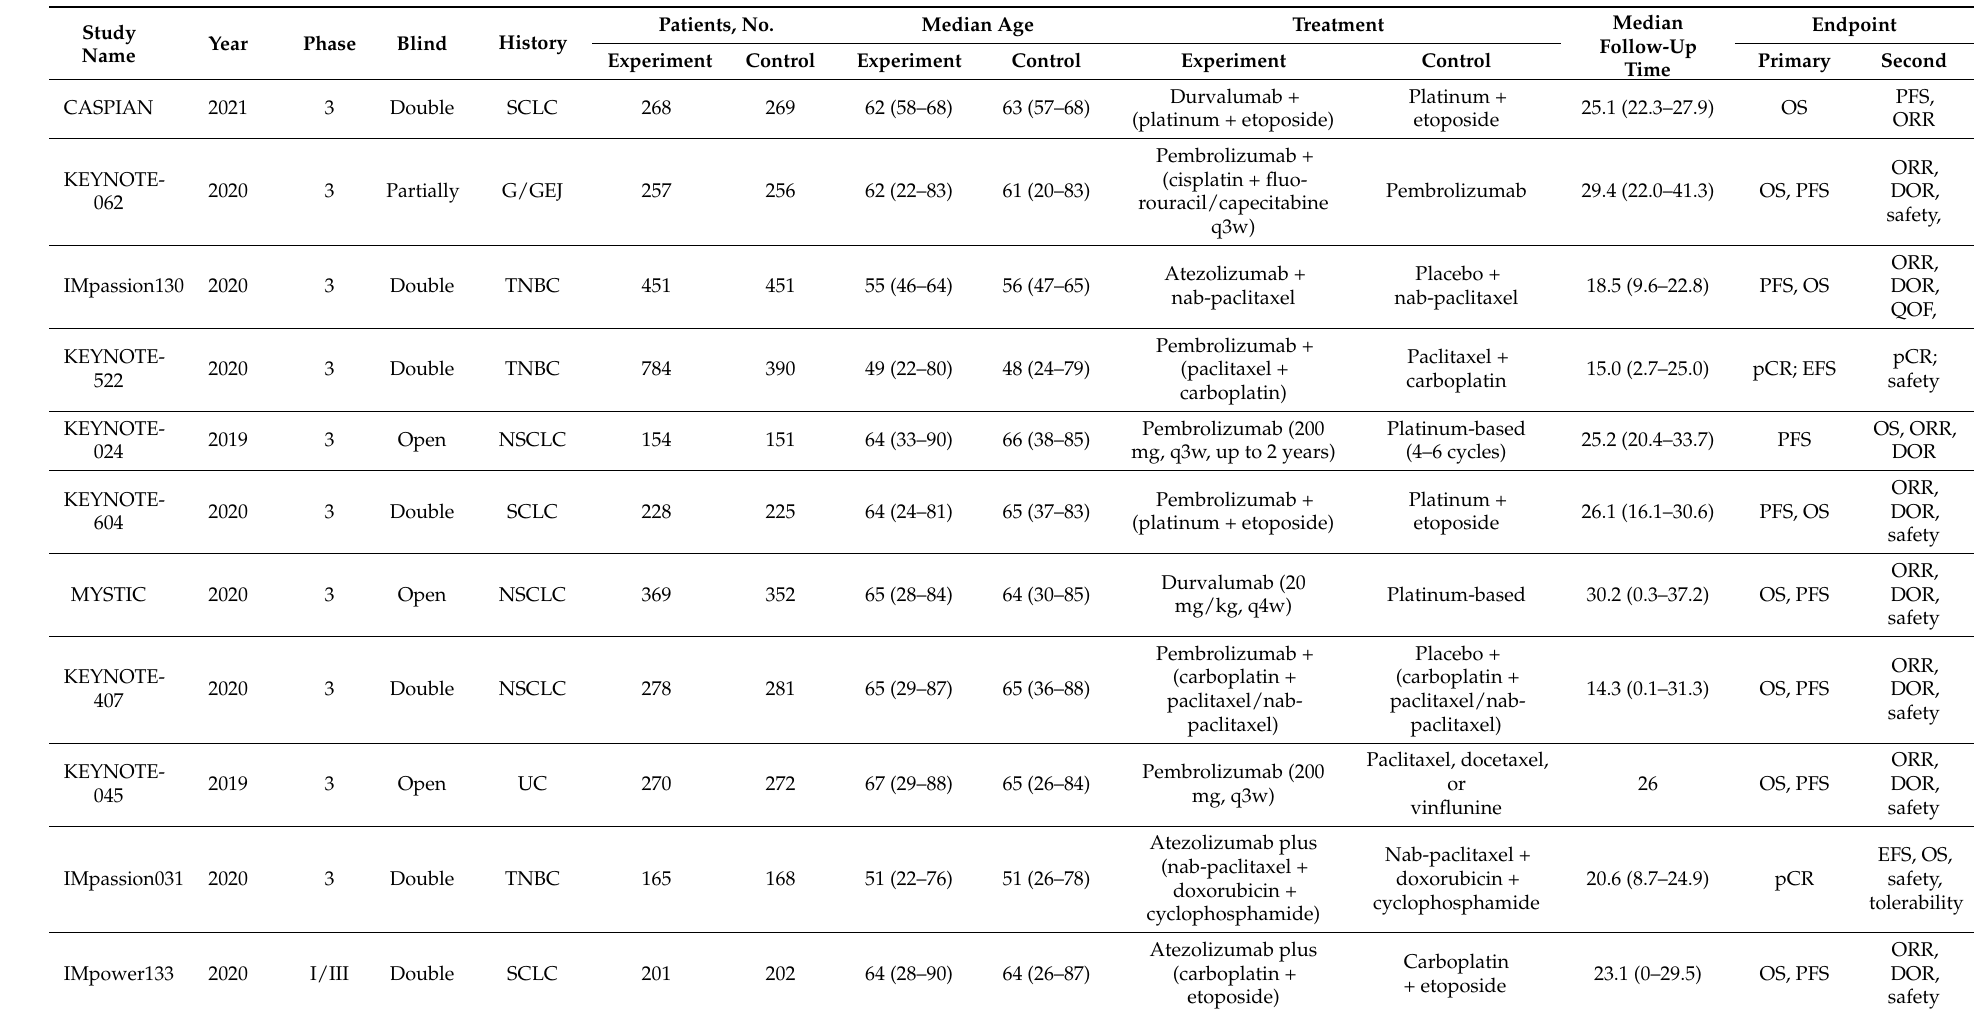
Table 1. Demographic characteristics of included random clinical trails